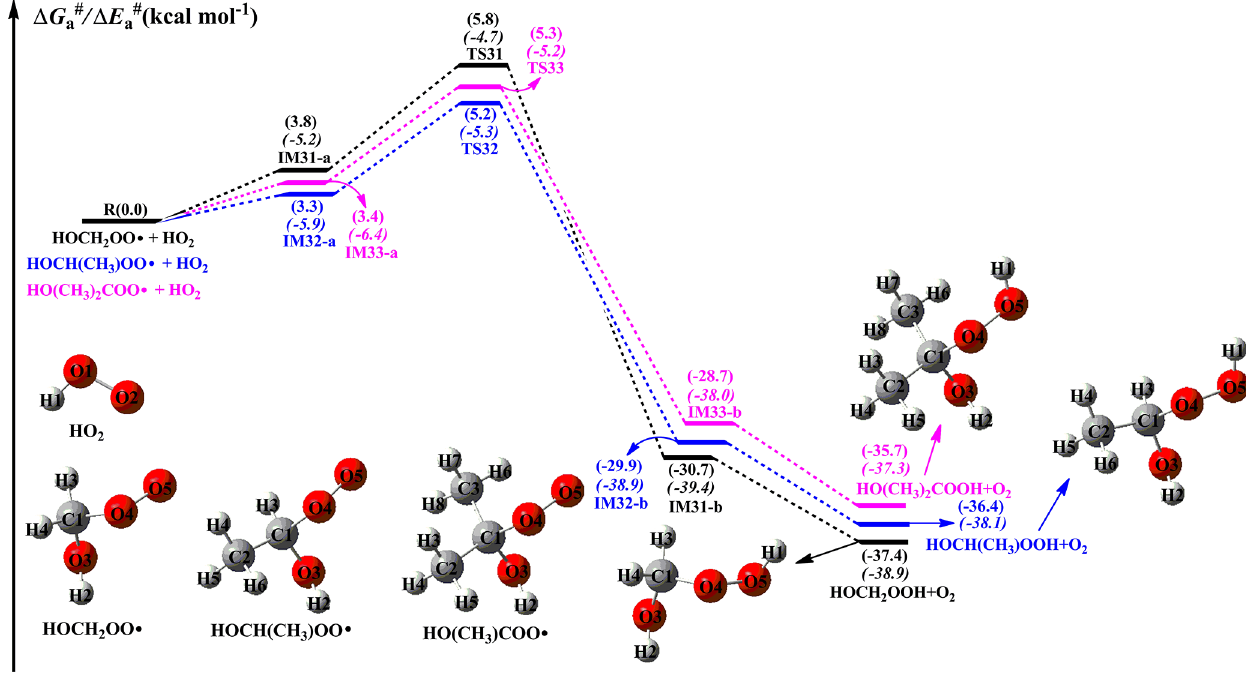
Figure 8. PES ( (cid:49)G # a and (cid:49)E # a , in italics) for the reactions of distinct RO 2 radicals with the HO 2 radical predicted at the M06-2X/ma-